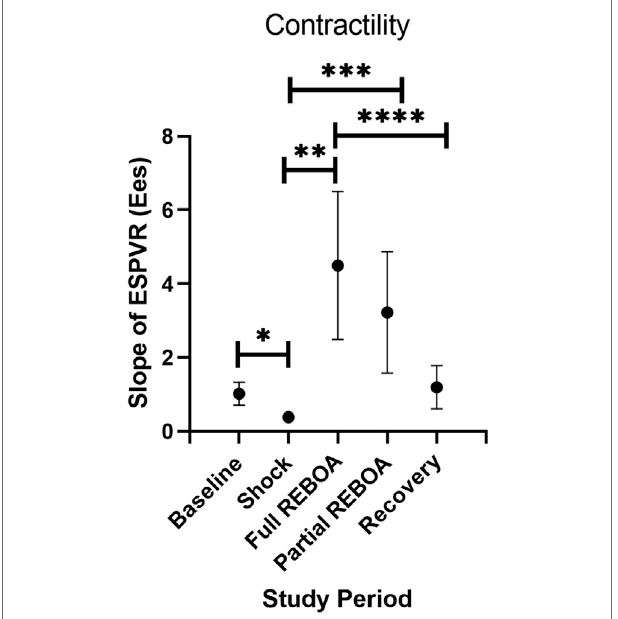
FIGURE 5 | End Systolic Elastance (Ees; the slope of the ESPVR) evolution across study periods. *p = 0.003, **p = 0.002, ***p = 0.01, ****p